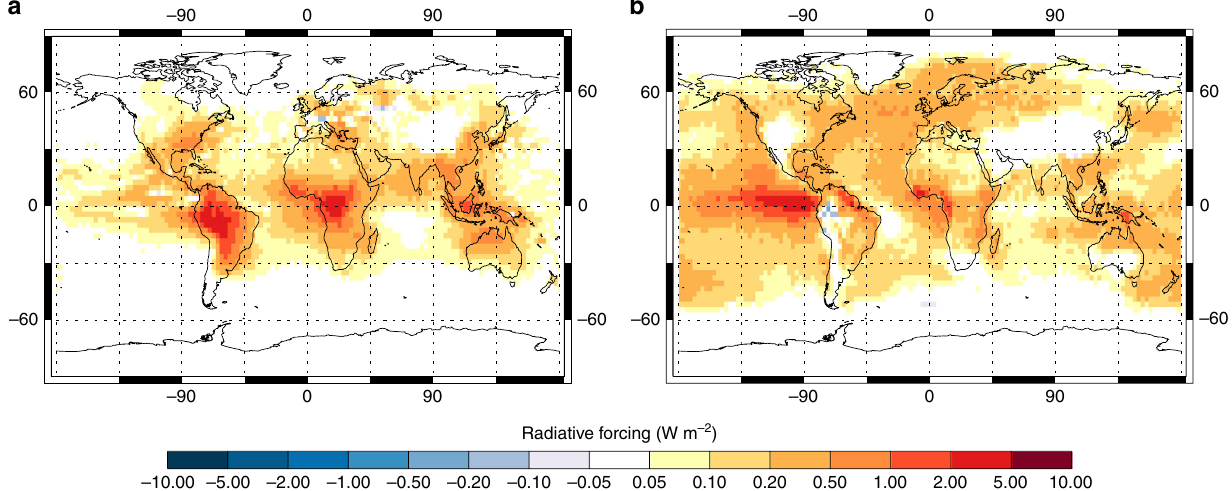
Fig. 2 Aerosol radiative effects due to global deforestation. Direct radiative forcing ( a ) and fi rst indirect radiative forcing ( b Figure 1 summarises the annual mean RFs due to changes in (Fig. 2 and Supplementary Fig. 2). The different scenarios the concentrations of SLCFs under global and regional deforesta- highlight a latitudinal sensitivity to deforestation, with tropical tion scenarios. Global deforestation results in a positive global deforestation accounting for 80% of the DRF due to global annual mean aerosol direct radiative forcing (DRF) of 0.17 W m − 2 deforestation. (all values also given in Supplementary Table 2). This positive RF Global deforestation causes a global annual mean fi rst aerosol occurs due to the reduced production of biogenic SOA, meaning indirect radiative forcing (IRF) of 0.20 W m − 2 , due to a reduction in the global annual mean concentration of particles able to form that fewer particles grow large enough to interact directly with cloud droplets. The spatial pattern of the IRF is more complex radiation in the atmosphere. The largest DRF occurs over tropical − 2 than the DRF (Fig. 2) but the strongest IRF also occurs at tropical regions, exceeding 2 W m over the Amazon and Congo forests